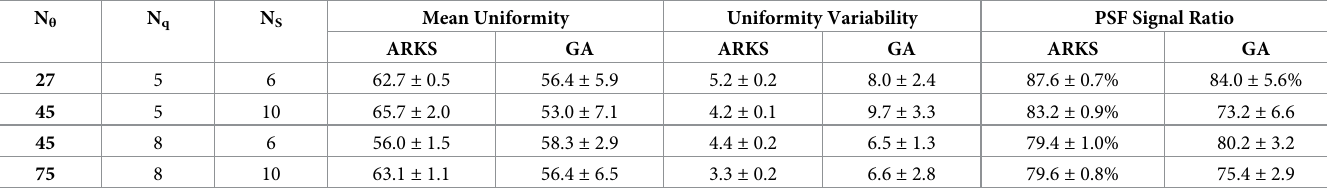
Table 2. Mean and variability of k-space uniformity for golden-angle and autonomous